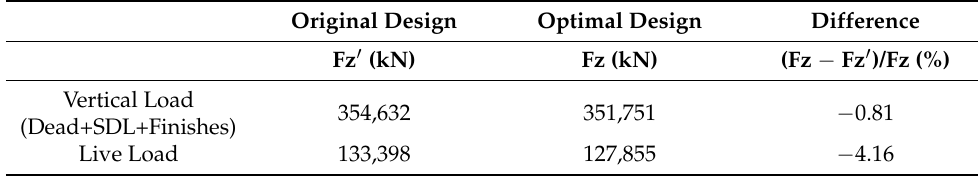
Table 6. Comparison of column total reactions.